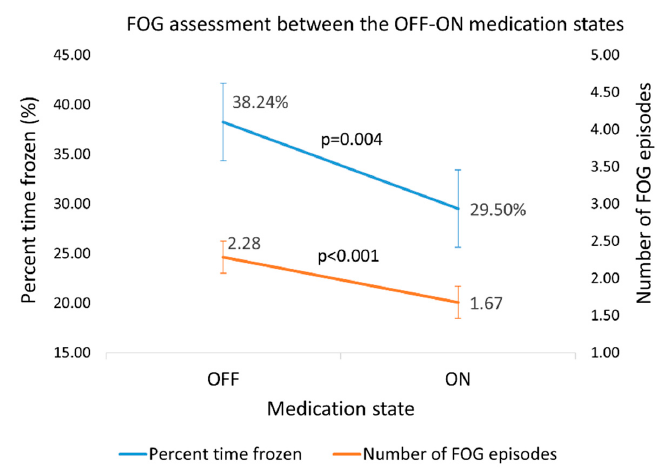
Figure 6. Percent time frozen and the number of FOG episodes, as detected by the new algorithm in the OFF–ON states. Error bars reflect ± 1 standard errors.